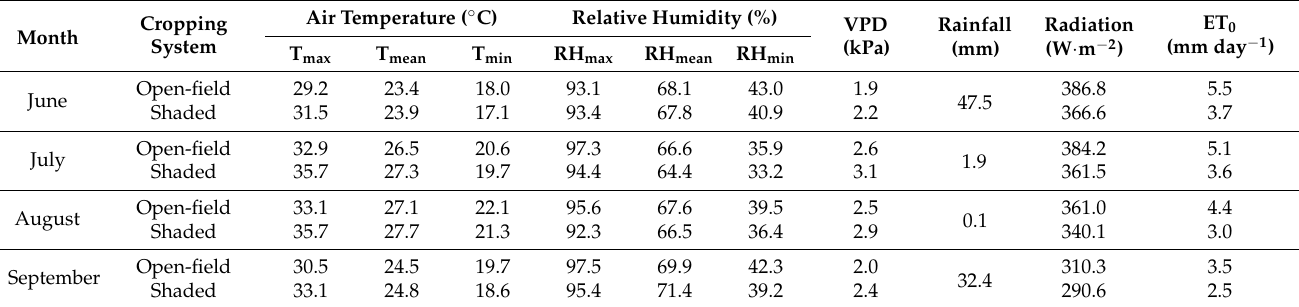
Table 1. Monthly values of maximum, mean and minimum air temperatures (T max , T mean and T min , respectively), and relative humidity (RH max , RH mean , RH min , respectively), mean vapor pressure deficit (VPD), rainfall, solar radiation, and crop reference evapotranspiration (ET 0 ) under open-field and shaded conditions during the experimental period (June to September 2021).